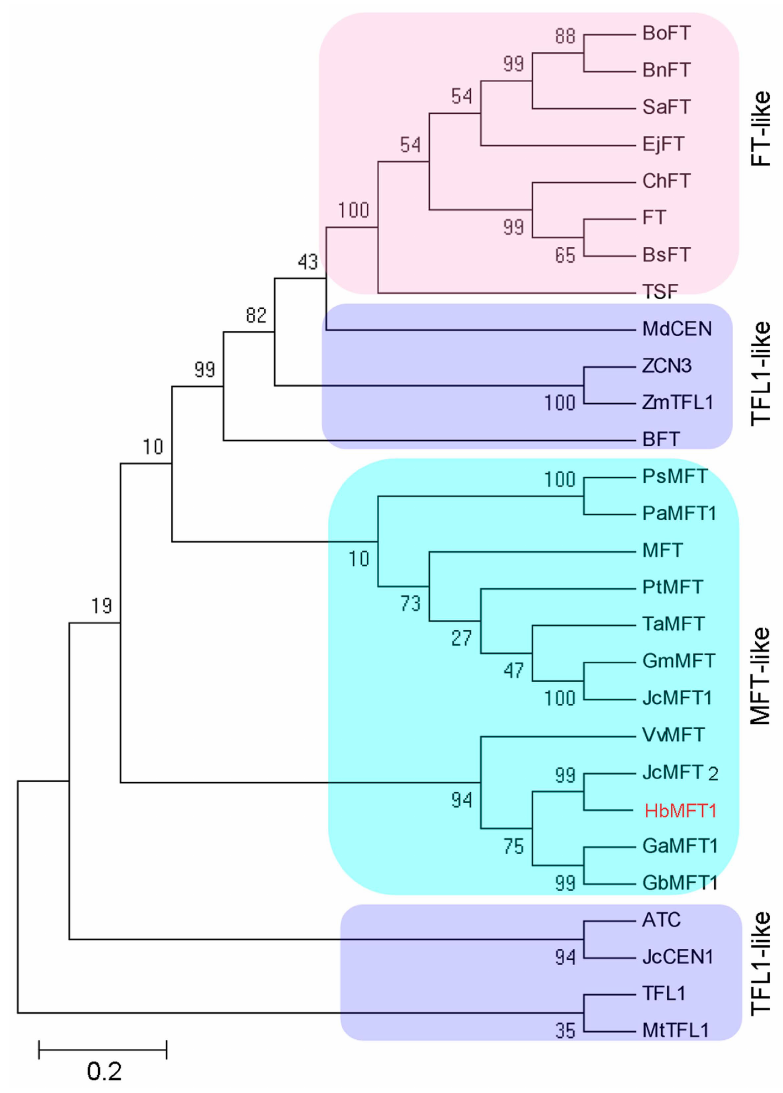
Figure 2. Phylogenetic analysis of the members in PEBP family. The tree was constructed using the Neighbor-Joining (N-J) method for members of the PEBP family in Hevea